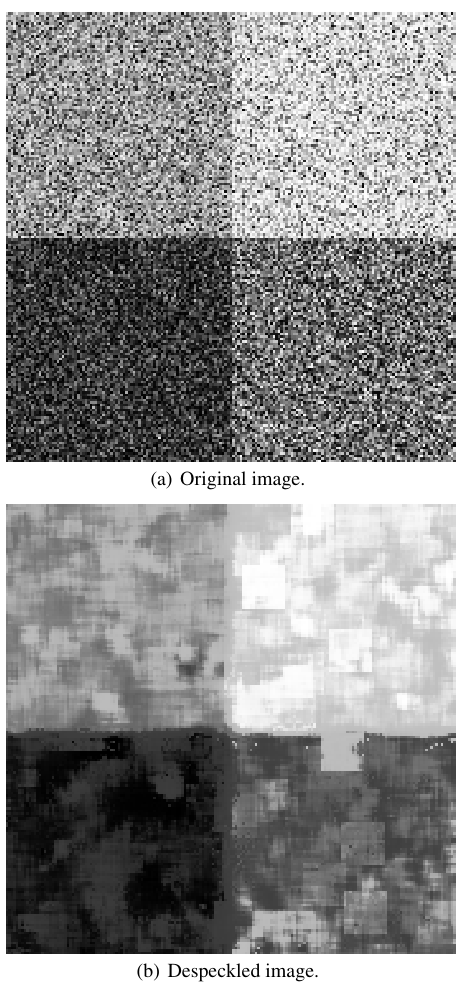
Figure 2. Result of applying the despeckling method using R´enyi entropy.